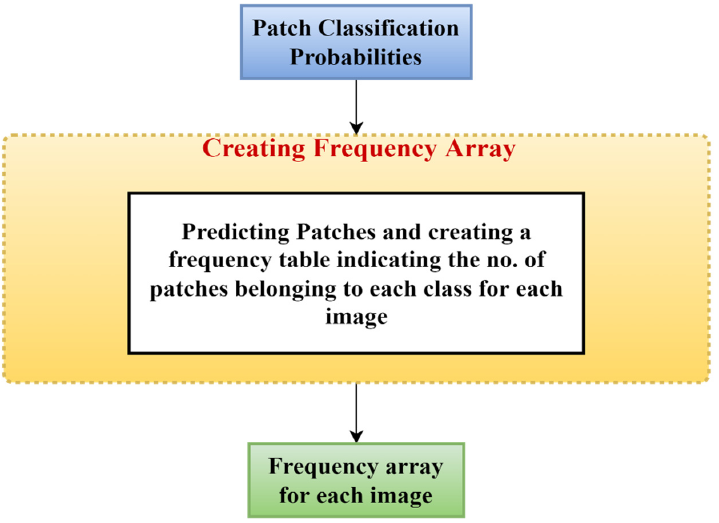
Figure 7. Creation of a frequency array for each image using the patch probabilities.